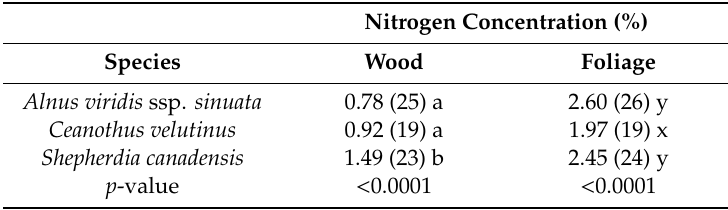
Table 6. Thirty-year post-treatment measures (means) pooled across basal diameter classes of nitrogen (N) concentration values (%) in the wood (branches) and foliage of the three N-fixing shrubs observed in the Miller Creek Demonstration Forest, Montana, USA. Sample numbers shown in parentheses. Di ff erent letters for each tissue type indicate a significant di ff erence among